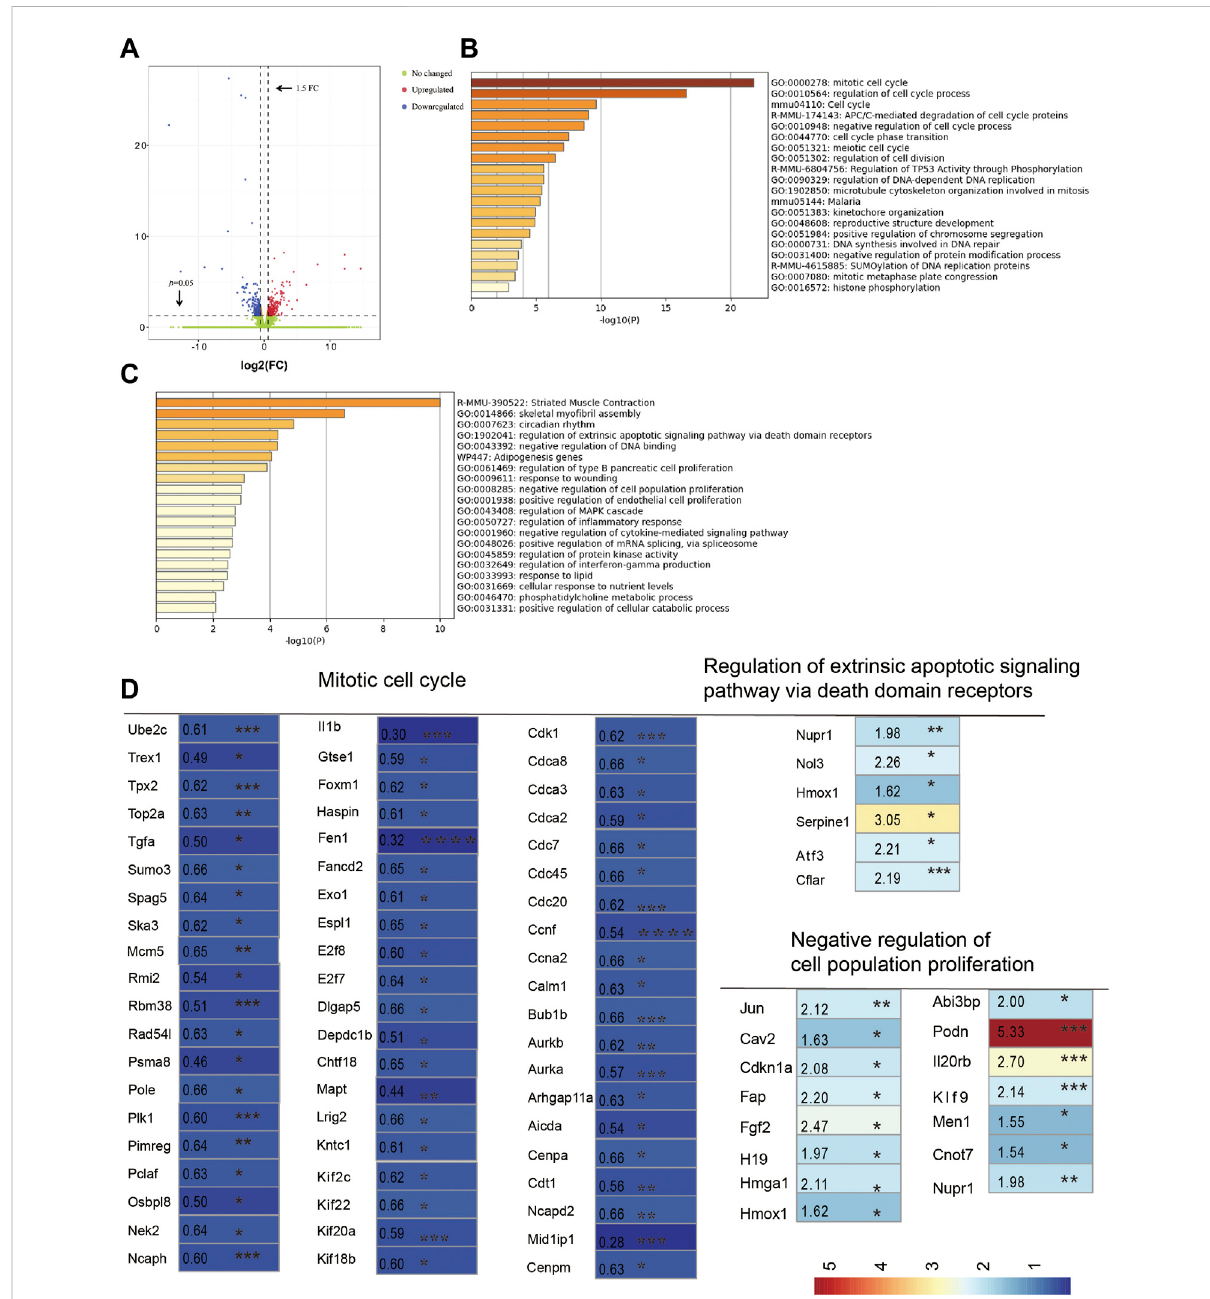
FIGURE 5 RNA sequencing analysis of ovaries. (A) Volcano plot showed variance in gene expression with regard to fold change and p -value. (B) Pathway and process enrichment analysis of downregulated gene lists (211) in depression-like mouse ovaries, colored by p -values. (C) Pathway and process enrichment analysis of upregulated gene lists (212) in depression-like mouse ovaries, colored by p -values. (D) Heat map was built by a panel of 80 differentially expressed genes, which were annotated in GO terms of the mitotic cell cycle, regulation of the extrinsic apoptotic signaling pathway via deathdomainreceptors,andnegativeregulationofcellpopulationproliferation(*** p < 0.001,** p < 0.01,and* p < 0.05).Student ’ s t -test was used for the comparisons between depression-like ( n = 3) and control mice ( n =